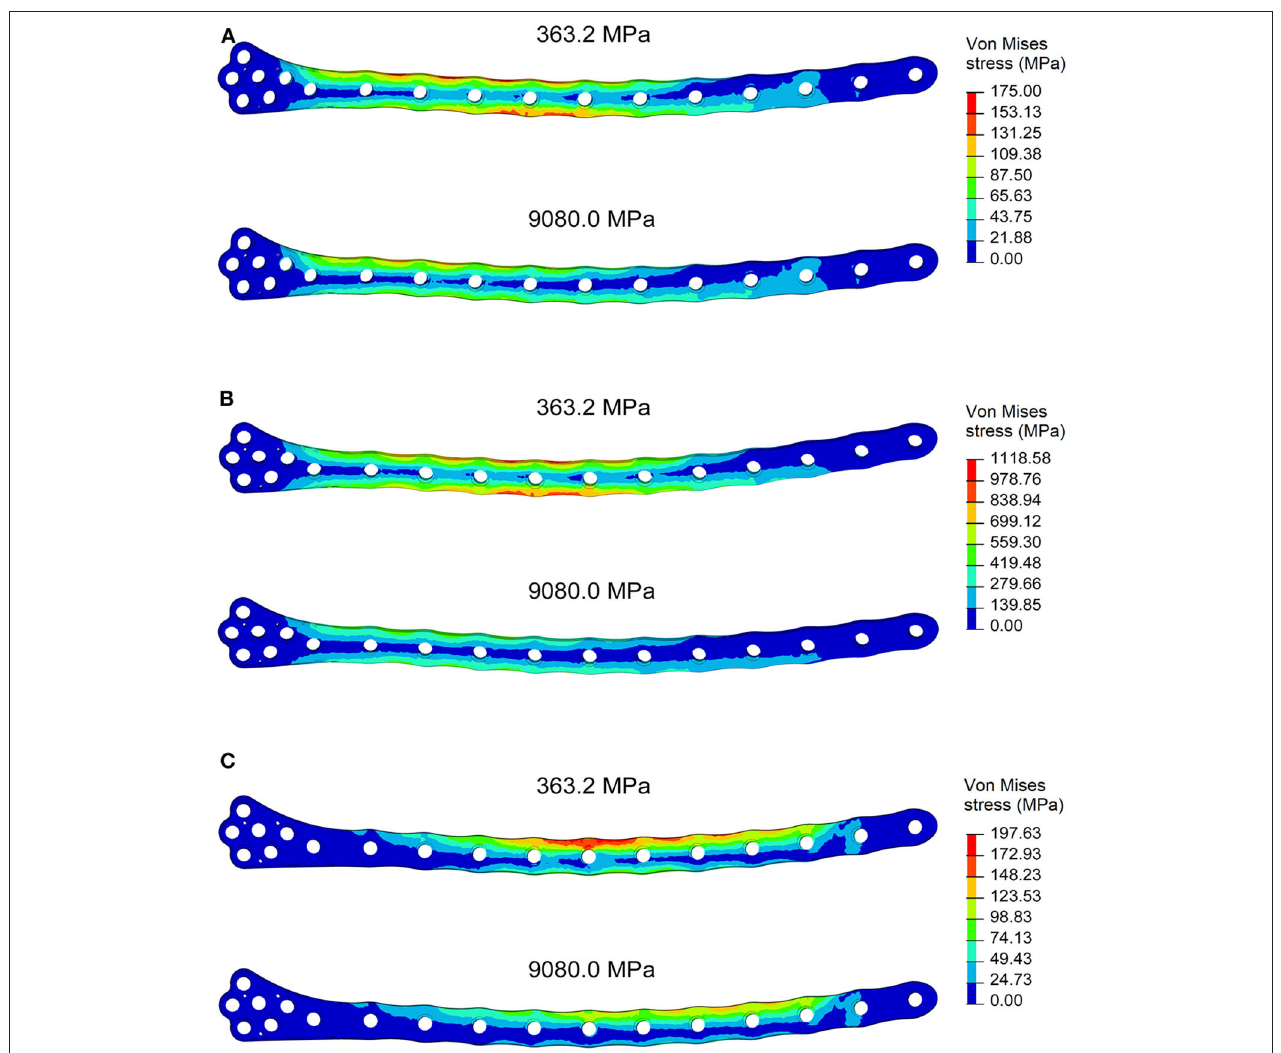
FIGURE 8 | Von Mises stresses distribution (MPa) in the plate for the models with bone callus Young’s modulus 363.2 and 9080.0 MPa resulting from (A) the walking condition, (B) the stumbling condition, and (C) the lateral falling